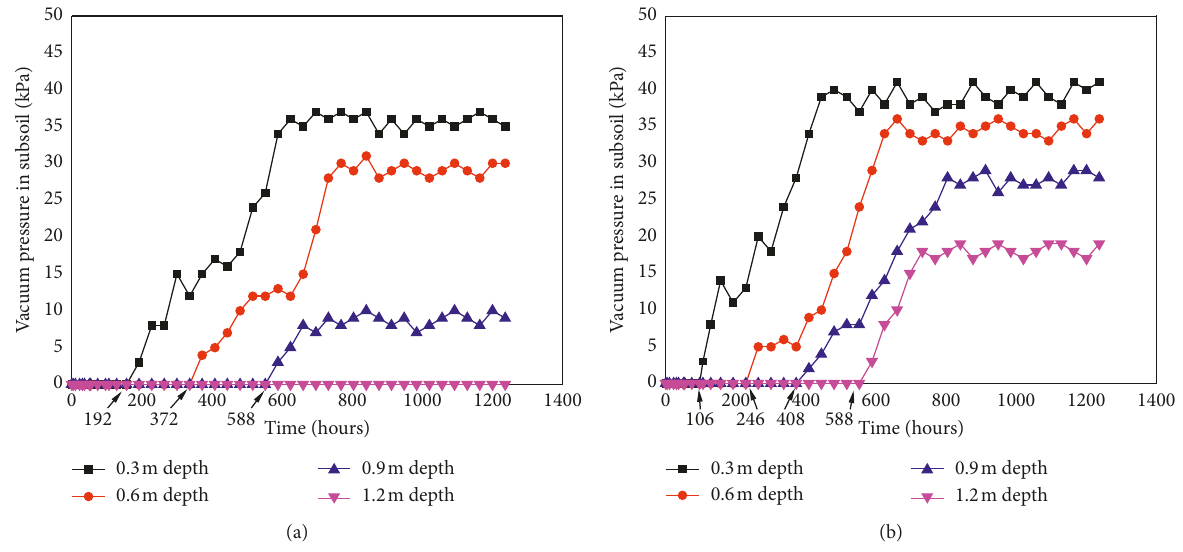
Figure 3: Vacuum pressures in the subsoils of cylinders (a) T 1 and (b) T